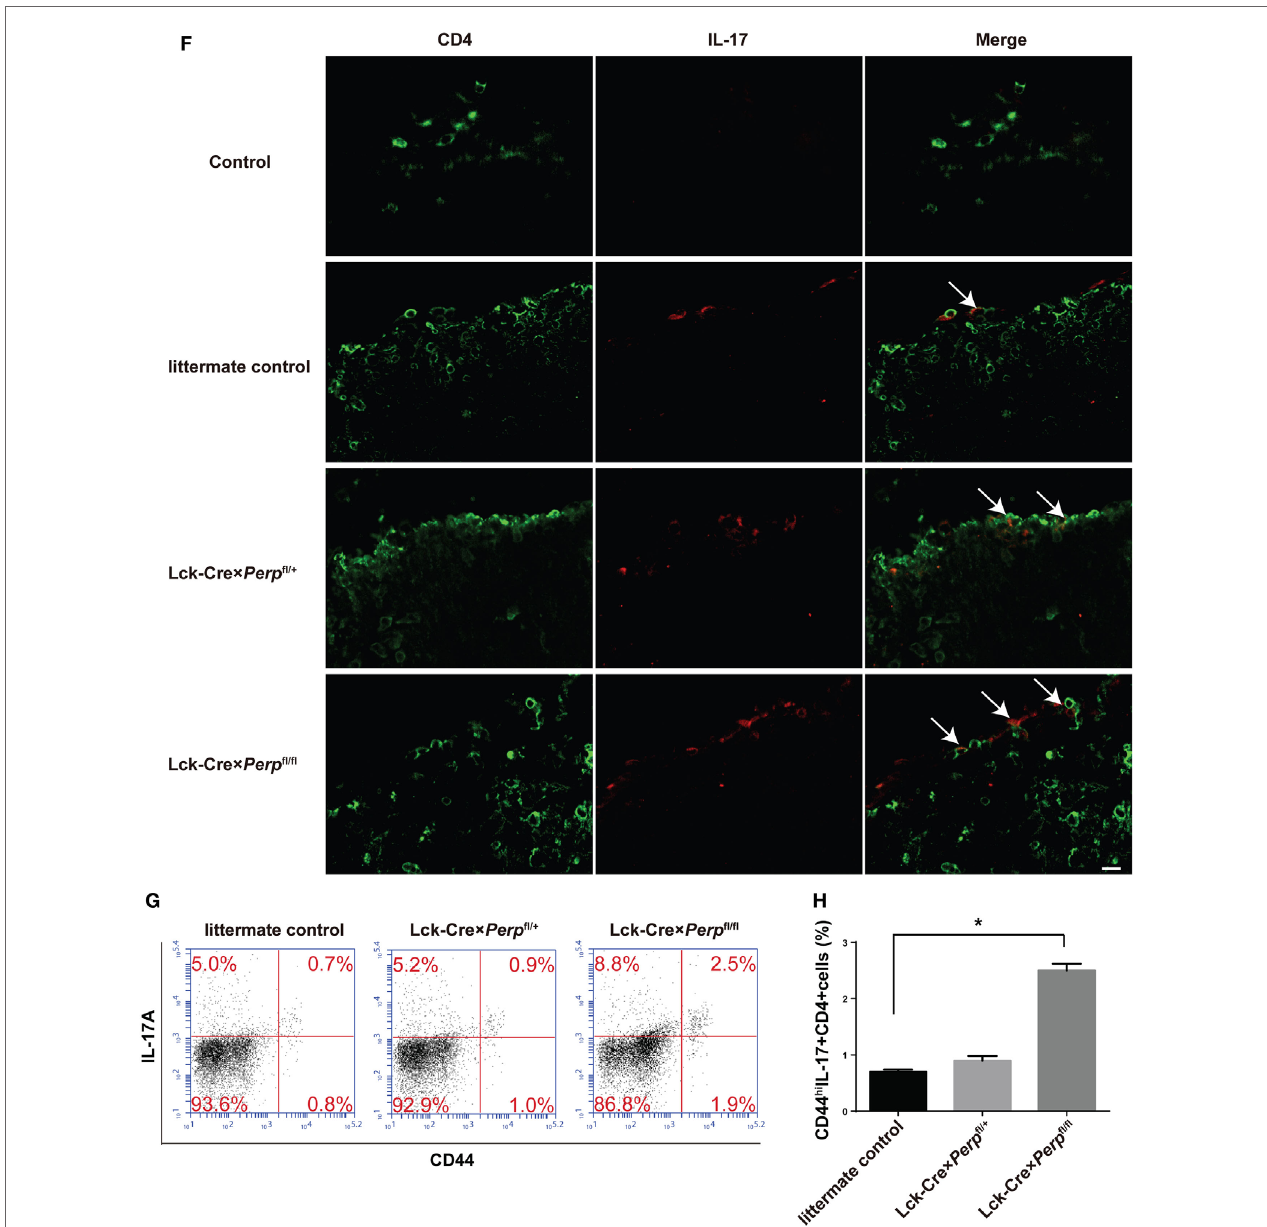
FigUre 7 | Increased frequency of T helper (Th17) cells in the peripheral spleen and spinal cord tissues in Lck-Cre × Perp fl/fl mice. At 23 days post-immunization, splenic mononuclear cells were isolated from littermate control, Lck-Cre × Perp fl/ + and Lck-Cre × Perp fl/fl mice. The cells were stained with anti-CD4, fixed, permeabilized, and intracellularly stained with anti-IFN- γ and anti-IL-17A. Some cells were stained with anti-CD4, anti-CD25, fixed, permeabilized, and intracellularly stained with anti-Foxp3. The percentages of Th1, Th17 cells, and Tregs were determined by FACS. In addition, the presence of Th17 cells in the spinal cord tissues was characterized by immunofluorescent assay. The cryostat spinal cord tissue sections were stained with anti-CD4 (Alexa Fluor 488) and anti-IL-17A (PE), followed by imaging under a confocal microscope. Some splenic cells were stained with anti-CD4, anti-CD44, fixed, permeabilized, and intracellularly stained with anti-IL-17A. The percentages of splenic memory Th17 cells (CD4 + CD44 hi IL-17A + ) were determined by FACS. Data are representative images or expressed as the mean ± SEM of each group ( n = 8 per group) from three separate experiments. (a,c,D) The frequency of Th1 and Th17 cells. (B,e) The frequency of Tregs (* P < 0.05). (F) Immunofluorescence of CD4 (green) and IL-17 (red) in the spinal cord tissues. Calibration bar, 20 µm. (g,h) The frequency of splenic memory Th17